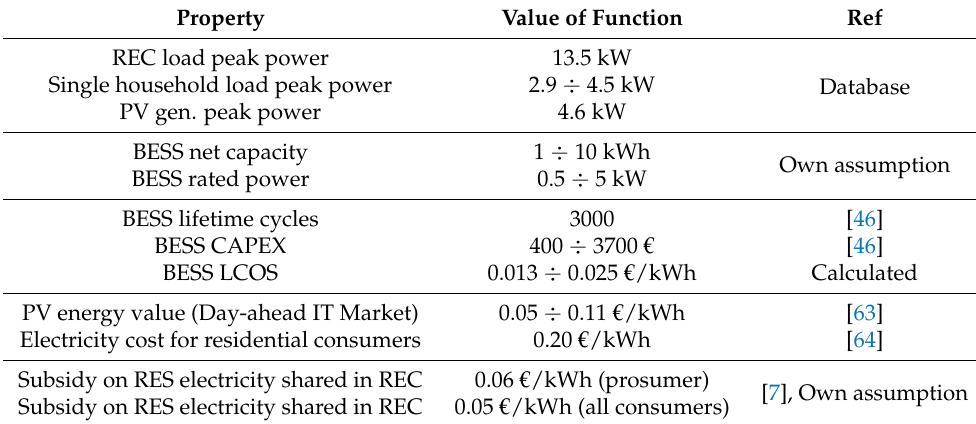
Table 1. Main simulation